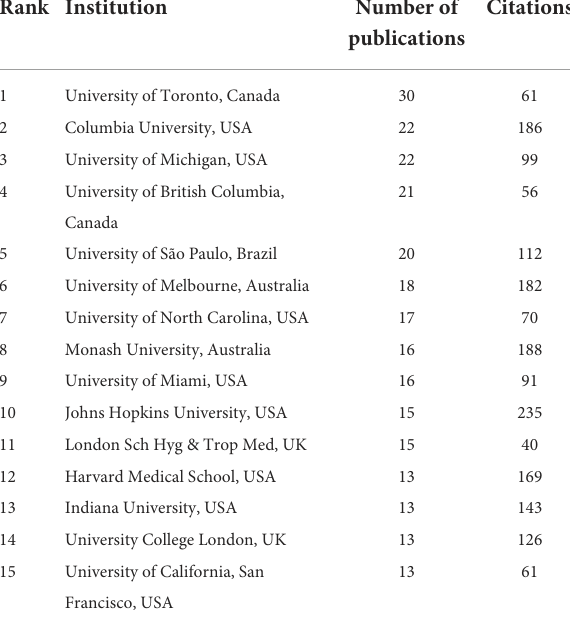
criteria. The geographic map of research countries and regions was mapped using the Tableau Public software (https://public.